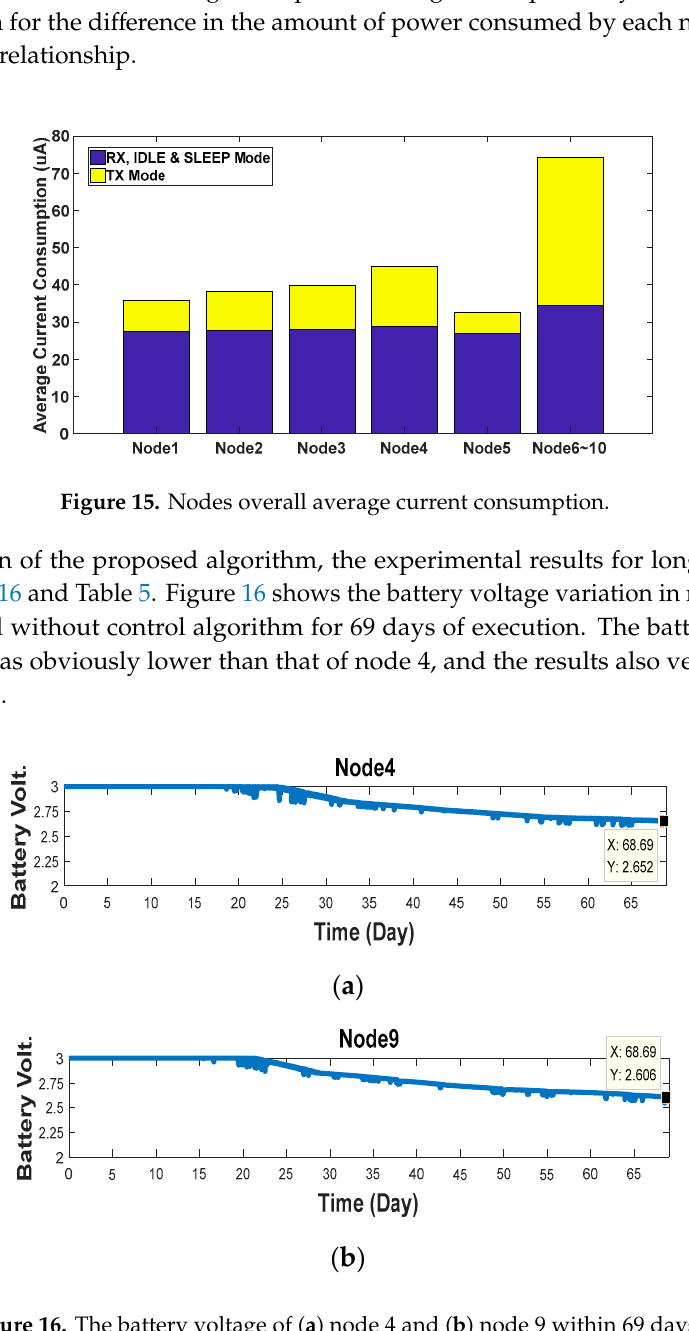
Figure 16. The battery voltage of ( a ) node 4 and ( b ) node 9 within 69 days. Table 5. The battery voltage of each node at the 69th day.